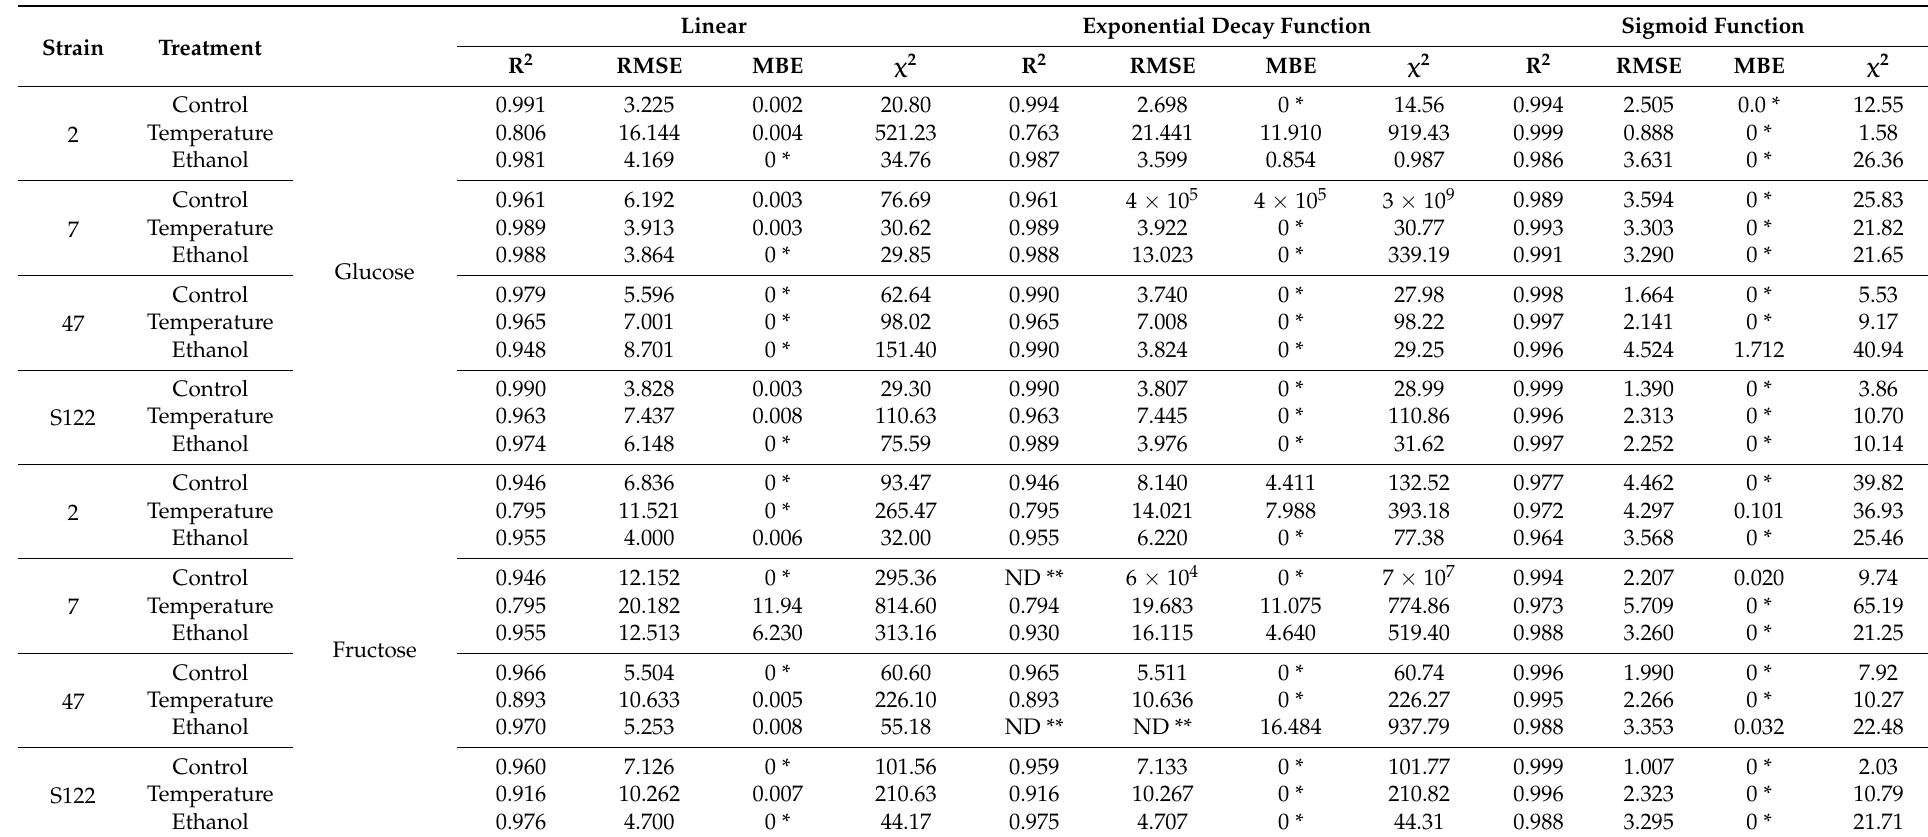
Table 4. Model and goodness of fit parameters (GOF) of the different models for glucose and fructose consumption (* if the value is lower than 10 − 4 , it was given as zero (0). ** ND: not detected, model not